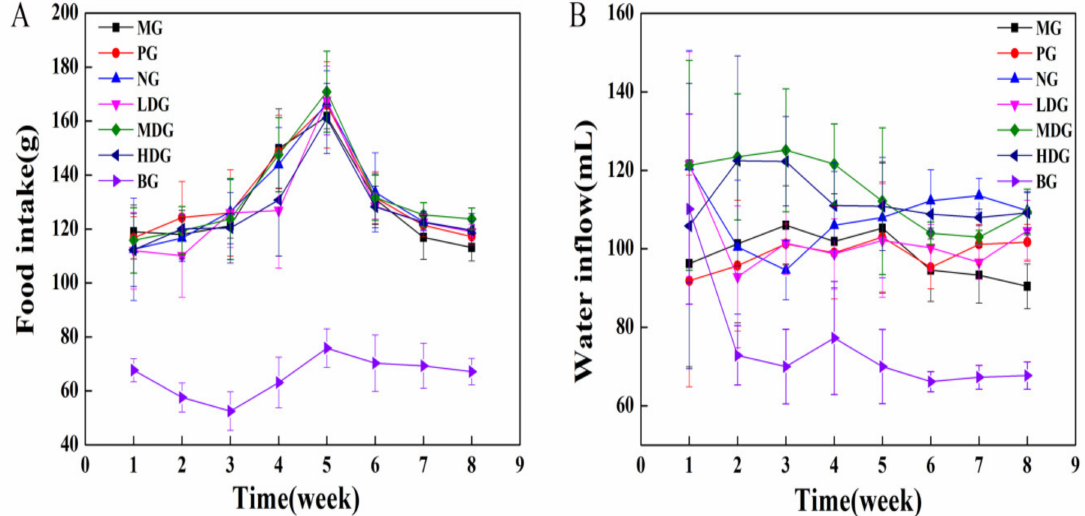
Figure 5. Food ( A ) and water ( B ) intake of